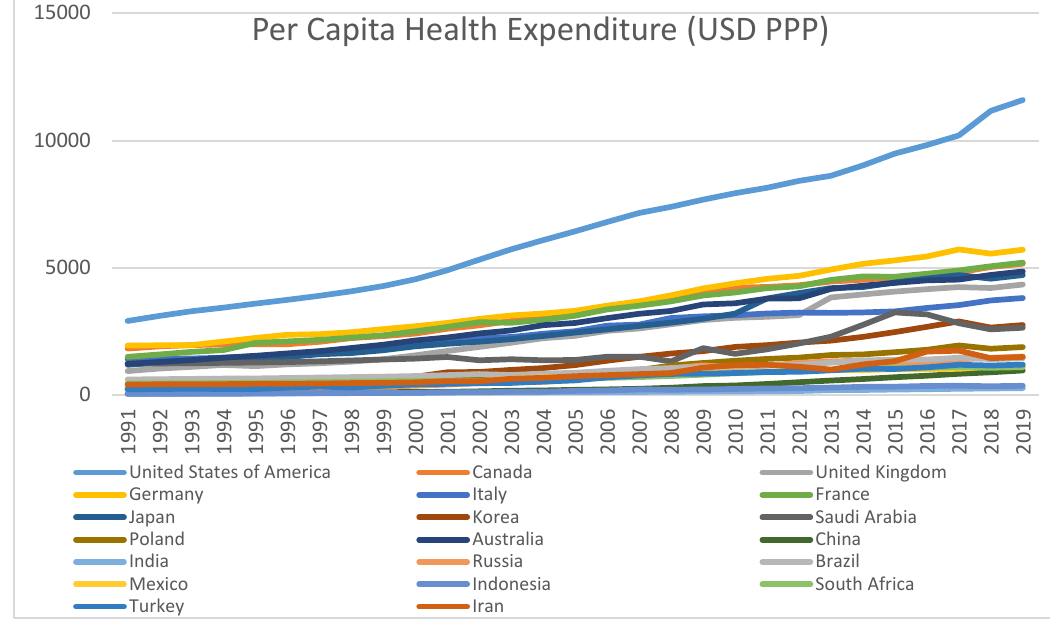
Figure 2. Per Capita Health Expenditure (USD PPP). Source: Author’s own derivations. Table 1. Descriptive statistics. Source: Author’s own